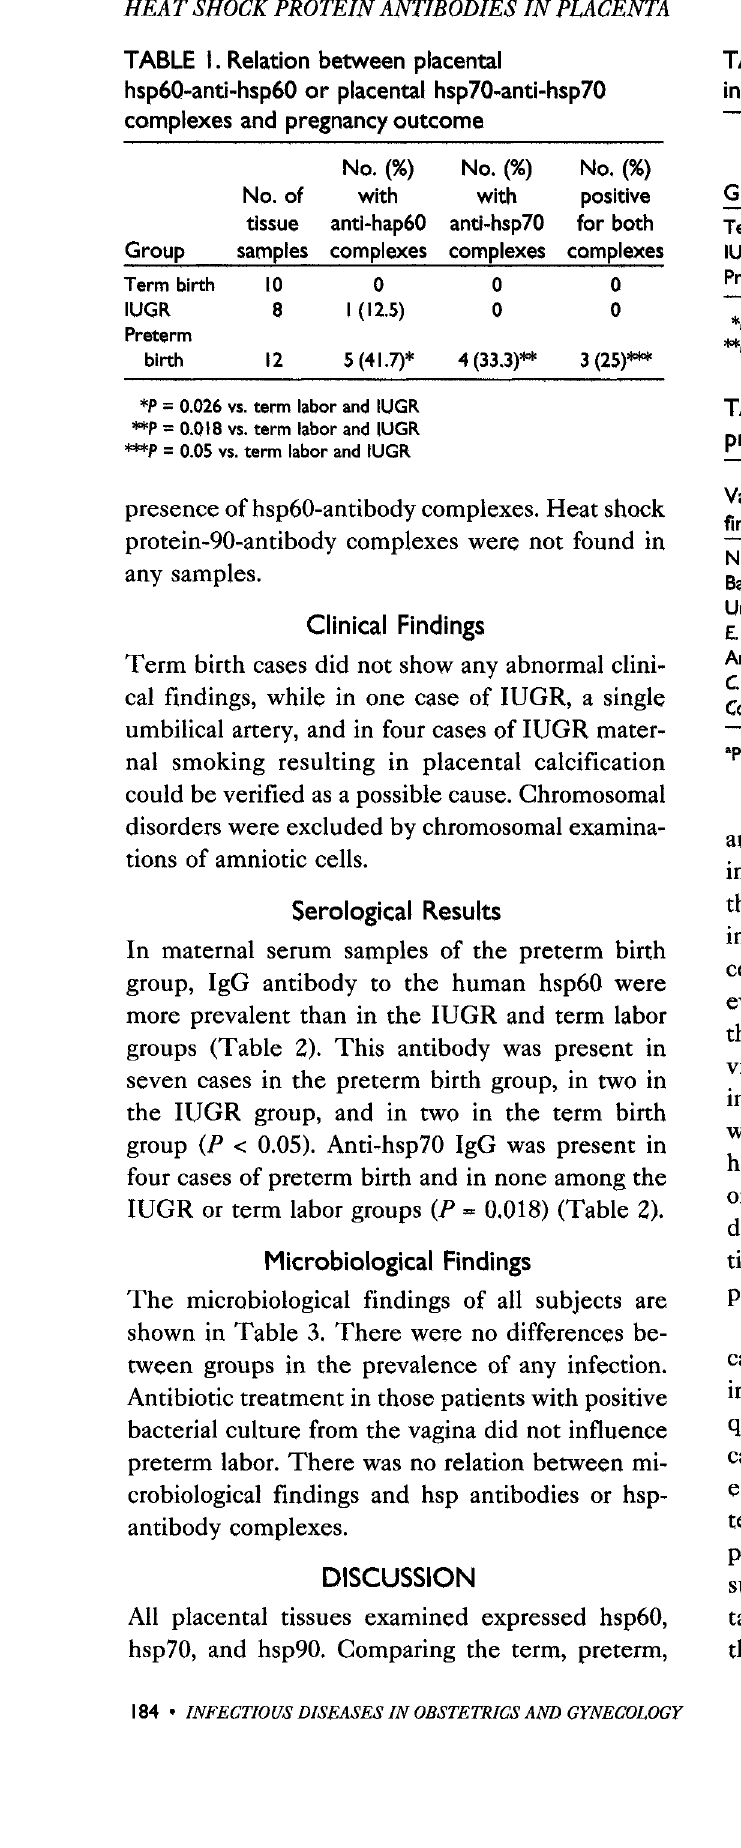
TABLE I. Relation between placental hsp60-anti-hsp60 or placental hsp70-anti-hsp70 complexes and pregnancy outcome No. (%) No. (%) No. (%) No. of with with positive tissue anti-hap60 anti-hsp70 for both Group samples complexes complexes complexes Term birth